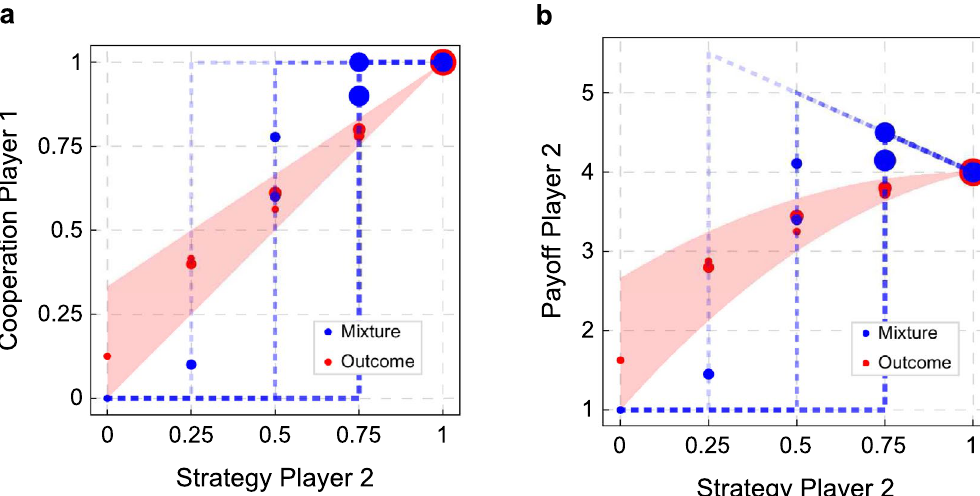
Figure 6. Cooperation rates and payoffs—strategy method (SM). On the x-axis we put the strategy chosen by each Player 2. On the y-axis we put: the frequency with which Player 2 induced the Players 1 he interacted with to play C ( a ), and the payoff Player 2 obtained ( b ). Dots’ size is proportional to the number of occurrences of that data point. Our theoretical model predicts blue points to be close to the dotted lines and red dots to be in the red areas. They are in remarkably good agreement with the observed behavior. n(Mixture) = 29; n(Outcome) =